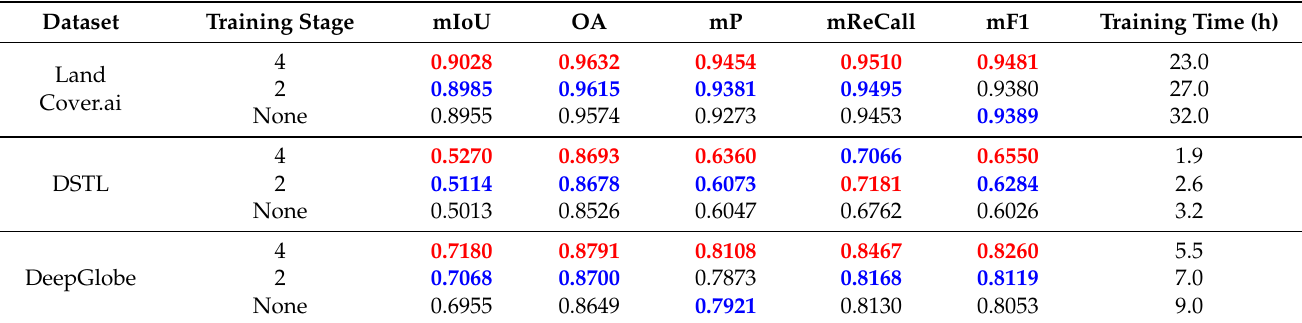
Table 6. The quantitative results of training strategy ablation experiments on the three datasets. (The red color and blue color indicate the best and the second-best performance). Dataset Training Stage mIoU OA mP mF1 Training Time (h) Land Cover.ai